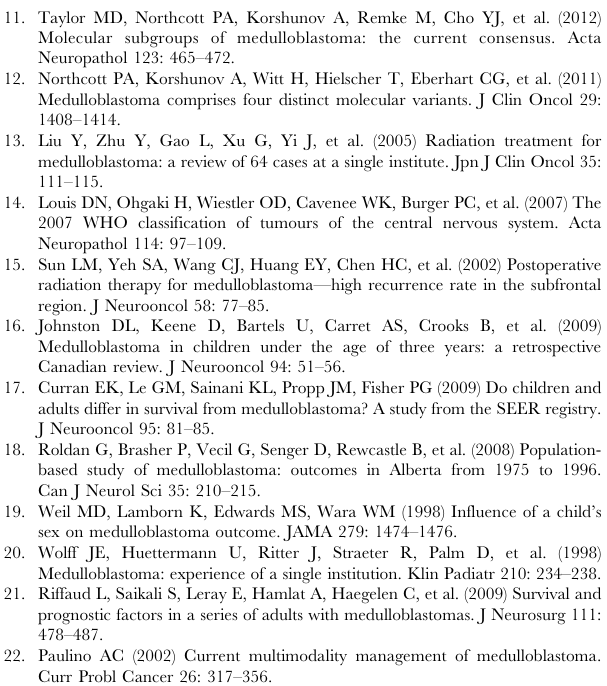
Figure S2 Survival analysis between WNT subgroup (green) and other molecular subgroups (SHH and Non- SHH/WNT subgroups, blue). a: OS analysis revealed WNT subgroup had significantly better survival than other groups; b : EFS analysis revealed WNT subgroup had a trend to significantly better survival than other groups. Table S1 Immunoreactivity patterns of SHH, WNT, and non-SHH/WNT molecular subgroups*. Table S2 Univariate analysis of postoperative adjuvant therapies for OS and EFS in children and adults with medulloblastoma (n= 173). Table S3 Univariate analysis of postoperative adjuvant therapies for OS and EFS in patients with different histological and molecular subgroups of medulloblasto- ma (n =173).